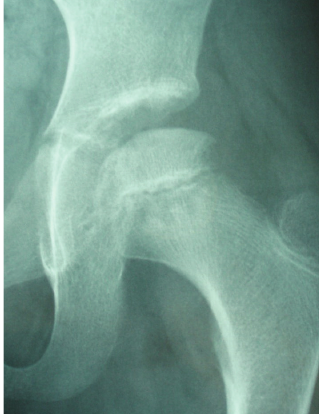
Figure 5: Plain radiograph of the hip joint 3 months after the initial visit. Bone resorption was observed at the left femoral capital epiphysis.